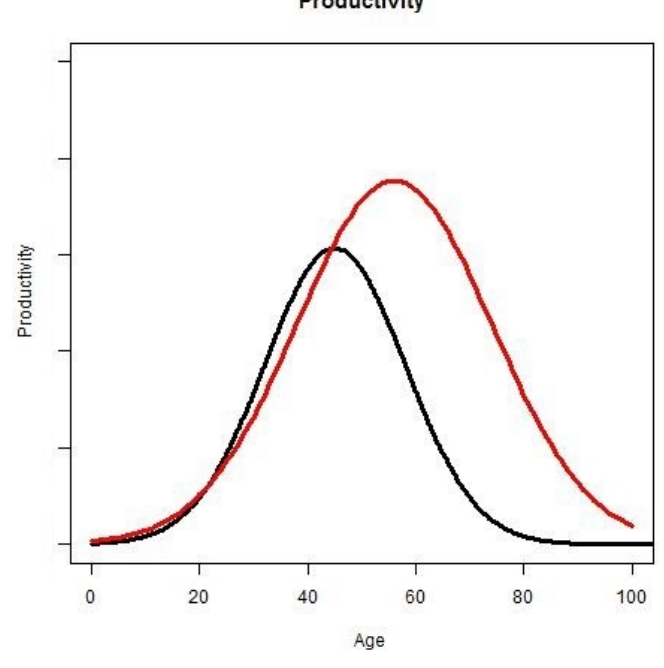
Figure 7. Productivity and rejuvenation rate. The X-axis represents age and the Y-axis represents productivity. The black curve illustrates the relative productivity with age without rejuvenation rate. The red curve illustrates the relative productivity with age with rejuvenation